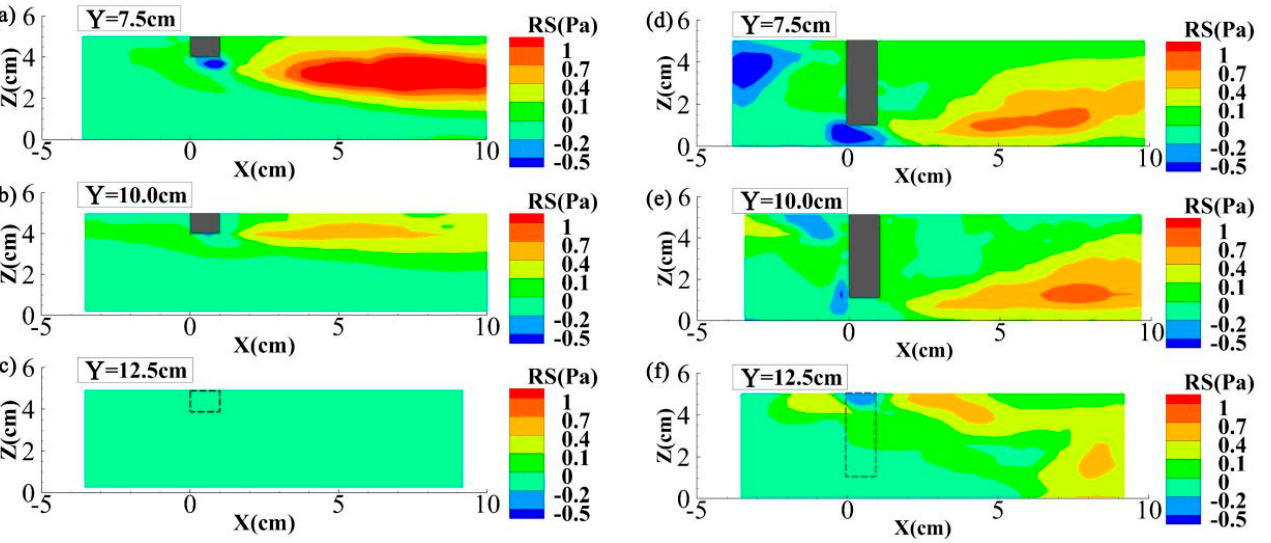
Figure 10. Distributions of the <u’w’> component of Reynolds stress at longitudinal sections ( a ) Y = 7.5 cm, ( b ) Y = 10.0 cm, ( c ) Y = 12.5 cm in Case 3 (on the left) and at longitudinal sections ( d ) Y = 7.5 cm, ( e ) Y = 10.0 cm, ( f ) Y = 12.5 cm in Case 4 (on the right). The grey areas in subfigures ( a ), ( b ), ( d ) and ( e ) demonstrate the floating dike, and the dotted lines in subfigures ( c ) and ( f ) indicate the location of floating dike in the coordinate system.